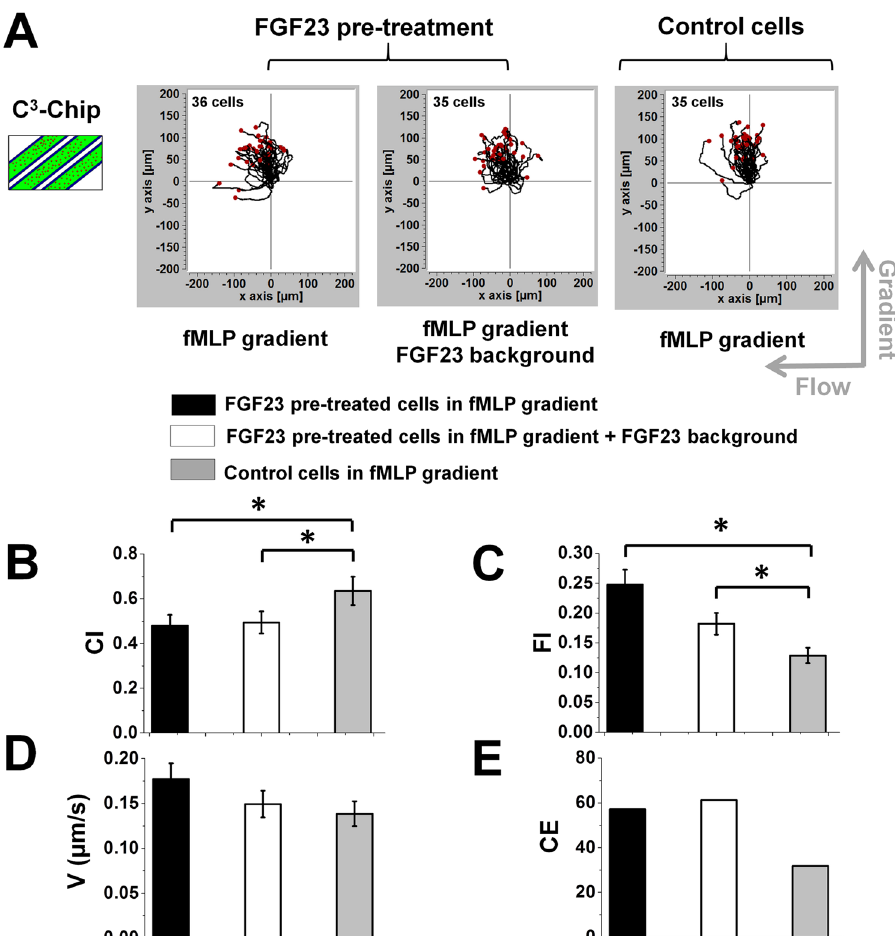
Figure 2. Chemotaxis of FGF23 pre-treated cells and un-treated control cells in the C 3 -Chip. ( A ) Cell migration tracks of FGF23 pre-treated cells in a 100 nM f MLP gradient with or without a FGF23 uniform background (left two plots) and cell migration tracks of un-treated control cells in a 100 nM f MLP gradient (right plot) in the C 3 - Chip. The cell tracks are normalized to have the same starting point in the plot. The gradient direction, the flow direction and the number of cells for each plot are indicated; ( B – E ) Comparison of quantitative cell migration parameters including chemotactic index (CI), flowtactic index (FI), speed (V) and chemotactic entropy (CE). The data for each parameter are presented as the average of all cells from representative experiments. The error bar indicates the standard error of the mean. * Indicates p < 0.05 for comparison between specific conditions using the Student’s t